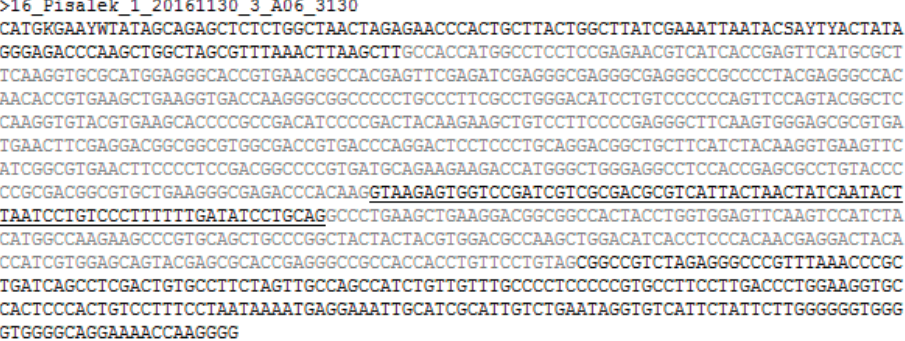
Fig. 2. Result of sequencing reaction shows precise cloning of intron within DsRed2 gene. Font in light grey depicts DsRed2 gene, font which is in black and underlined depicts intronic sequence and font in plain black is the sequence outside the DsRed2 gene.